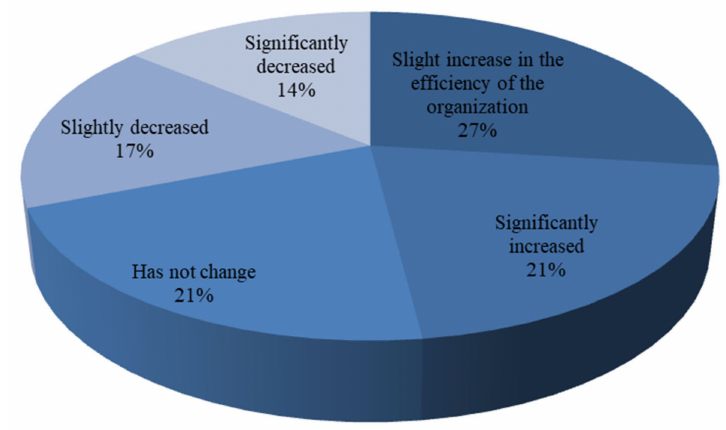
Figure 8. Assessment of changes in the efficiency the activity of the production enterprises of the Republic of Mordovia associated with the expansion of the use of ICT.